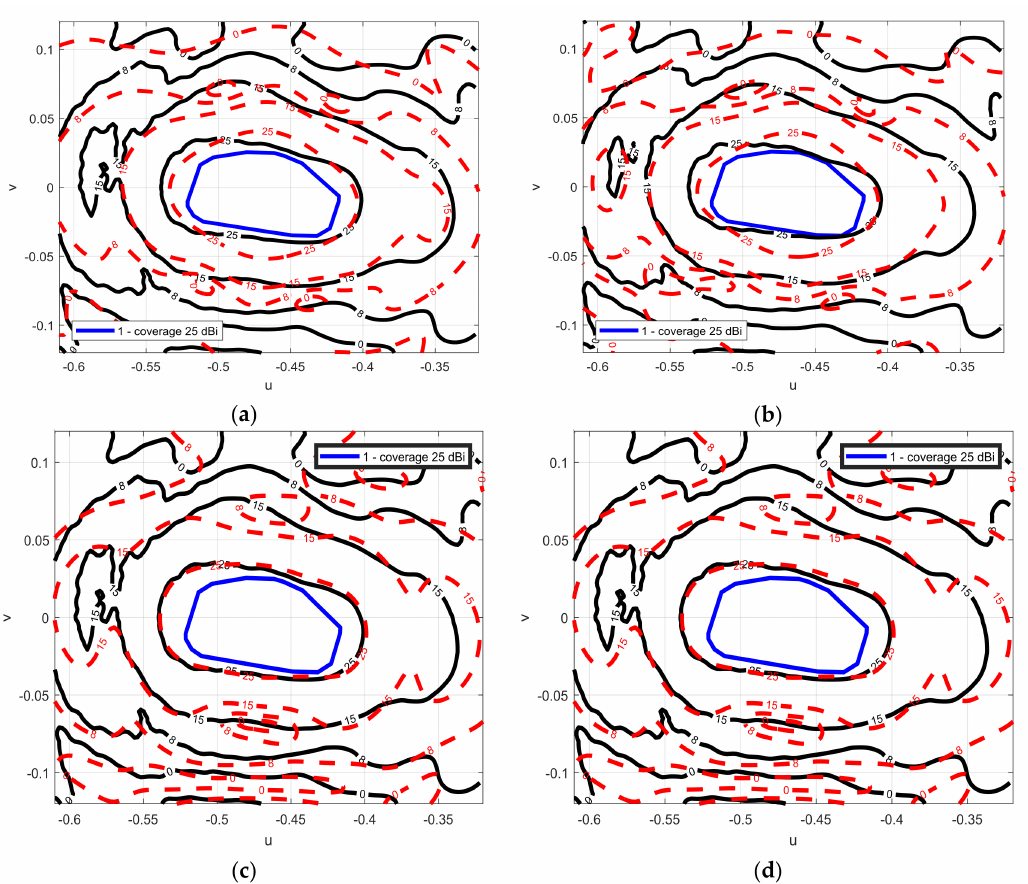
Figure 6. ( a ) Contour plots of the simulated copolar components of the radiation pattern (dashed red line (–)), measurements (solid black line (-)) and the mask (thicker solid blue line) for vertical polarization at 13.75 GHz; ( b ) for horizontal polarization at 13.75 GHz; ( c ) The simulations are repeated accounting for the phase errors (red line) and compared with measurements for vertical polarization; ( d ) for horizontal